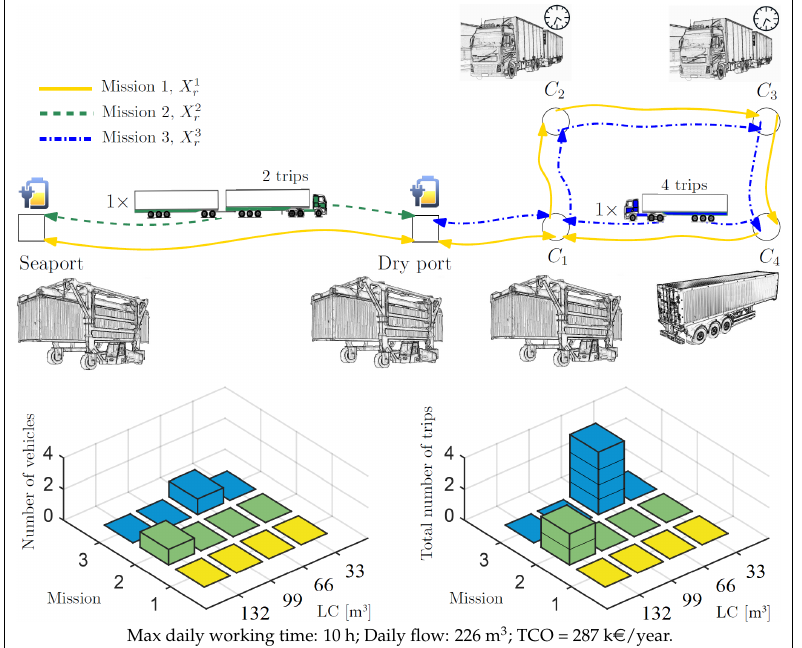
Figure 11. Optimum fleet for maximum daily working time of 10 h and daily flow of 226 m 3 ; fleet TCO equaled 287,000 e /year. LC denotes loading